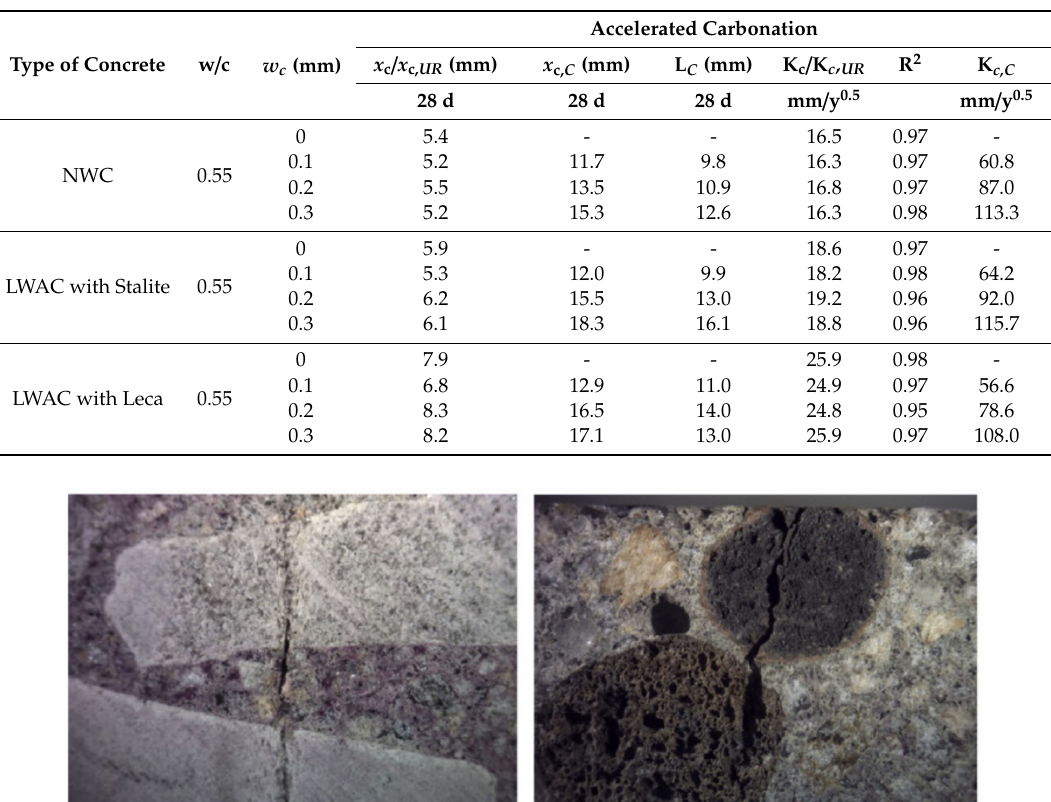
Table 4. Main results obtained in the accelerated carbonation test for uncracked reference concrete and concrete with artificial cracks [110], with copyright permission from Elsevier.